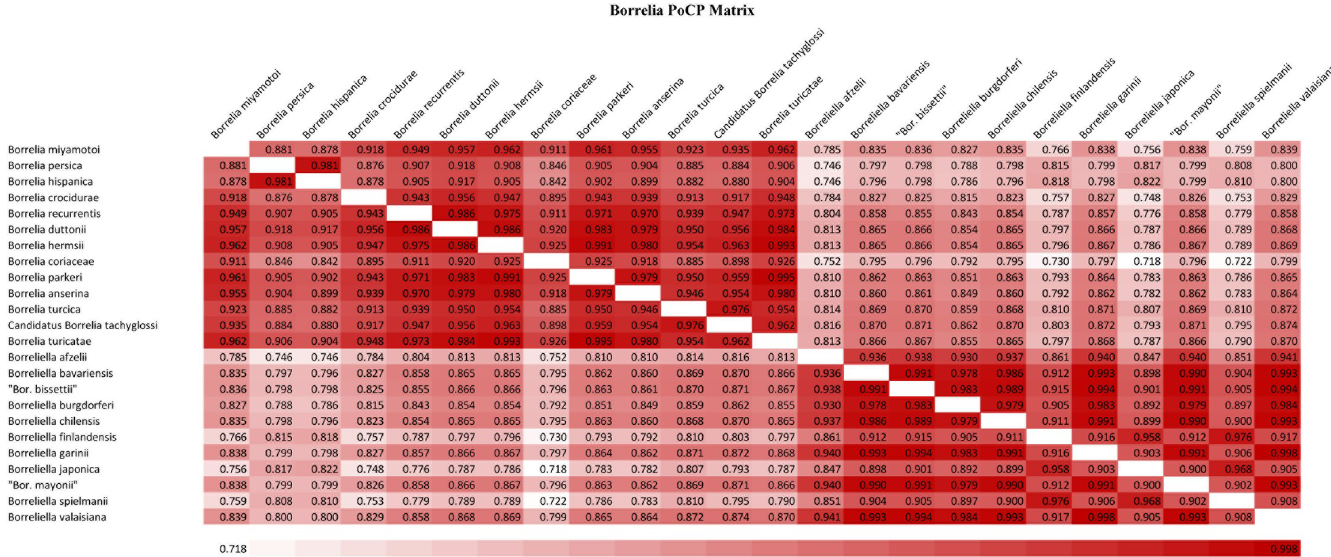
Fig 2. A pair-wise comparison matrix based on percentage of conserved proteins (POCP) in chromosomal genes from different genome sequenced Borreliaceae species. The matrix was constructed using an internally developed pipeline [13,14].Genome pairs sharing higher POCP are shaded more darkly (red). Based on their POCP values, species belonging to the family Borreliaceae form two main groups, with one group containing all of the LD and related species (or Borreliella ), and the other encompassing RF group of species together with the reptile-and echidna- associated species B . turcica and Candidatus Borrelia tachyglossi (genus Borrelia ).